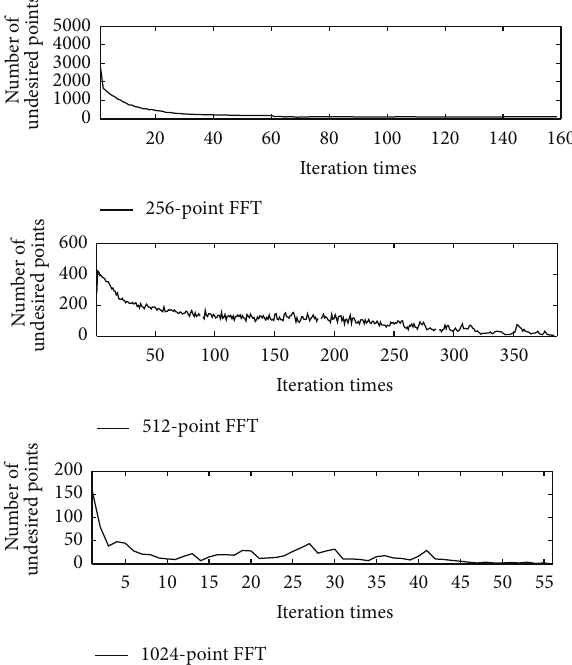
Figure 8: Number of undesired points versus iteration times.